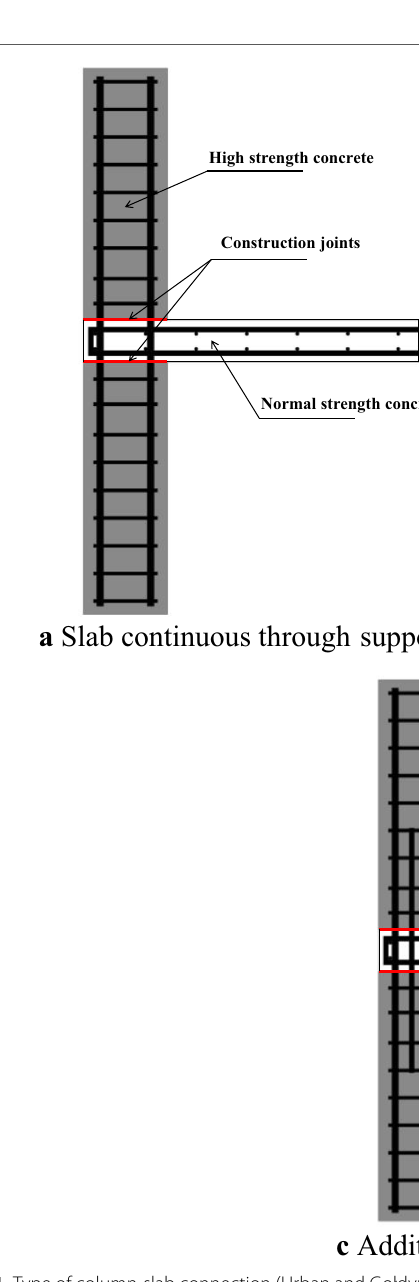
Fig. 1 Type of column‑slab connection (Urban and Gołdyn